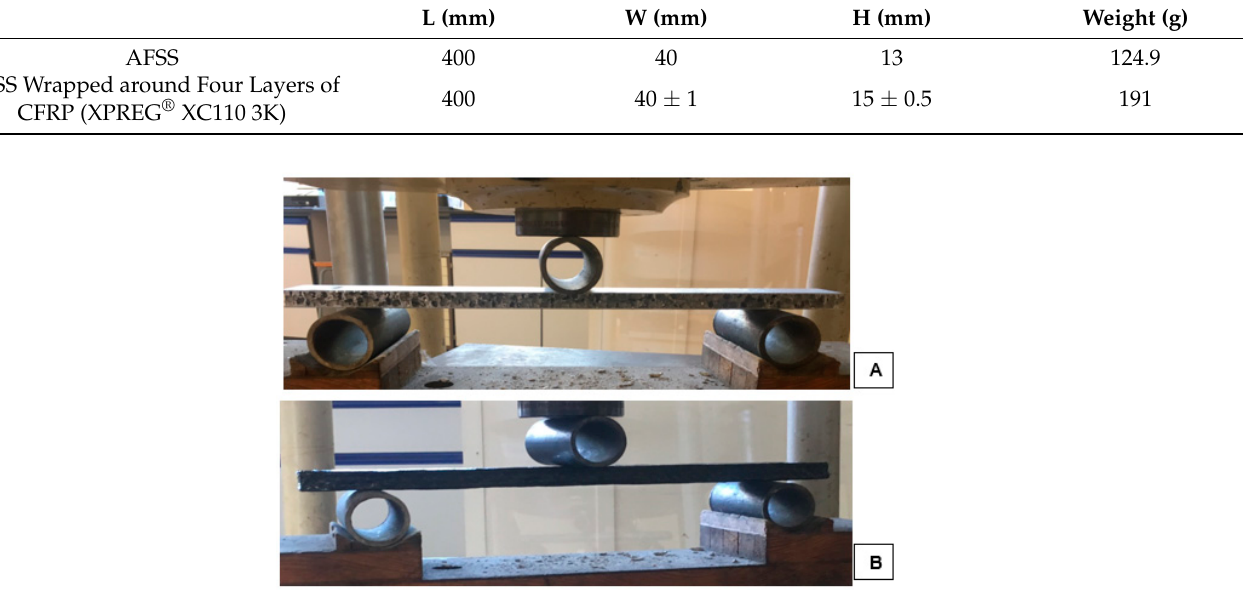
Figure 11. The large scale three-point bending test on ( A ) closed-cell AFSS and ( B ) closed-cell AFSS wrapped around four layers of CFRP (XPREG ® XC110 3K).